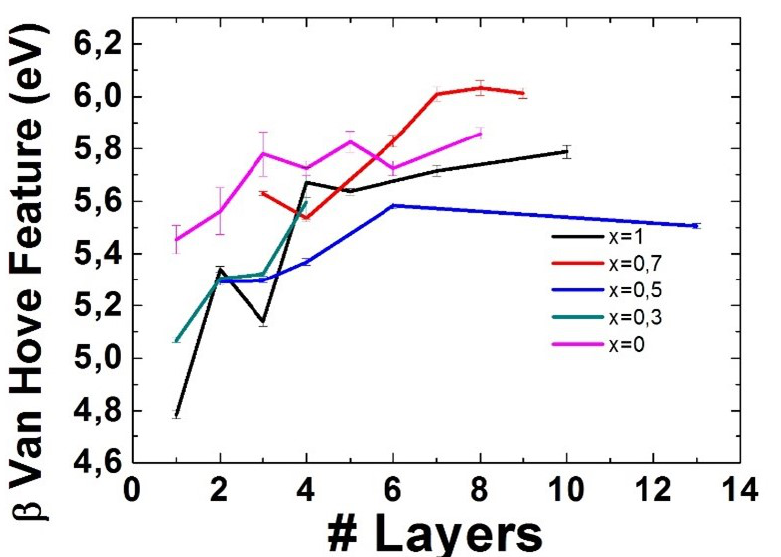
Figure 7. Position of the Gaussian fit corresponding to the β Van Hove feature for different number of layers and different alloying degrees. The error bars represent the error in the Gaussian fit for those layer numbers where only one measurement could be taken, and the standard deviation among measurements for those where several measurements could be